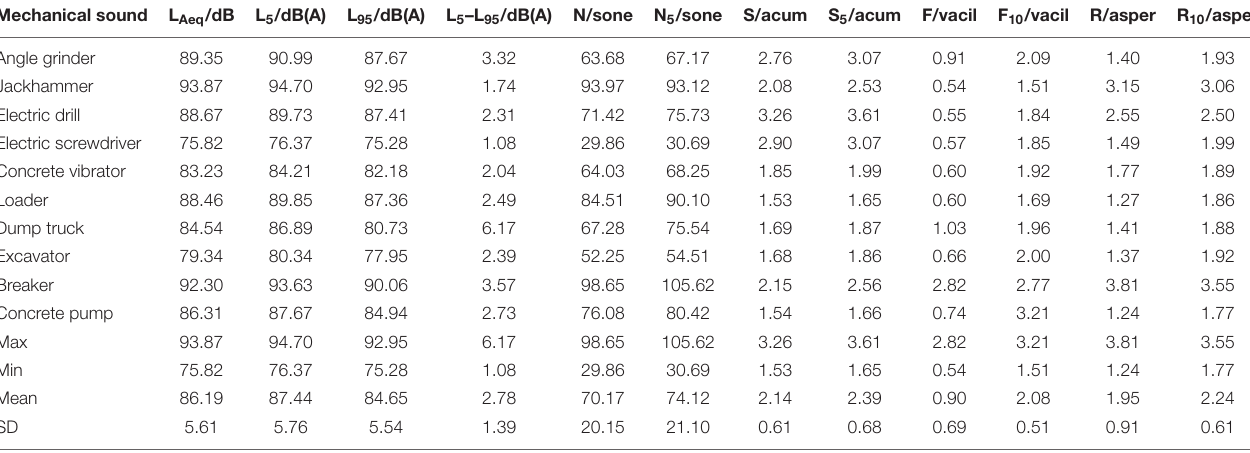
TABLE 6 | Results of physical and psychoacoustic indexes of ten typical noises.